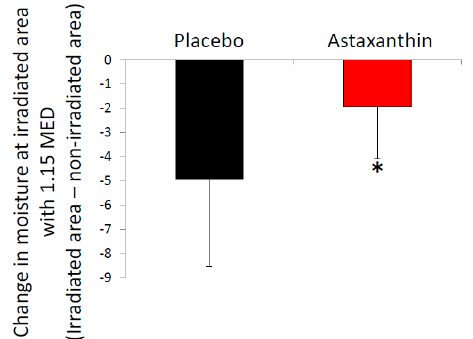
Figure 3. Dietary supplementation with astaxanthin attenuates the decrease of moisture at the irradiated area. Change in moisture from baseline at the irradiated area 7 days after irradiation. The moisture levels at the irradiated area were normalized by those at the non-irradiated area. * p < 0.05 by unpaired t -test. Error bars indicate the SD.